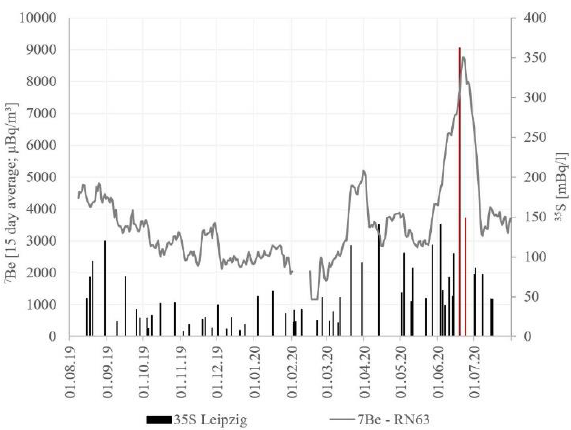
Figure 9. 35 S spike observed in Leipzig, Germany versus 7 Be spike detected at CTBTO station RN63 (Stockholm, Sweden) in June 2020.